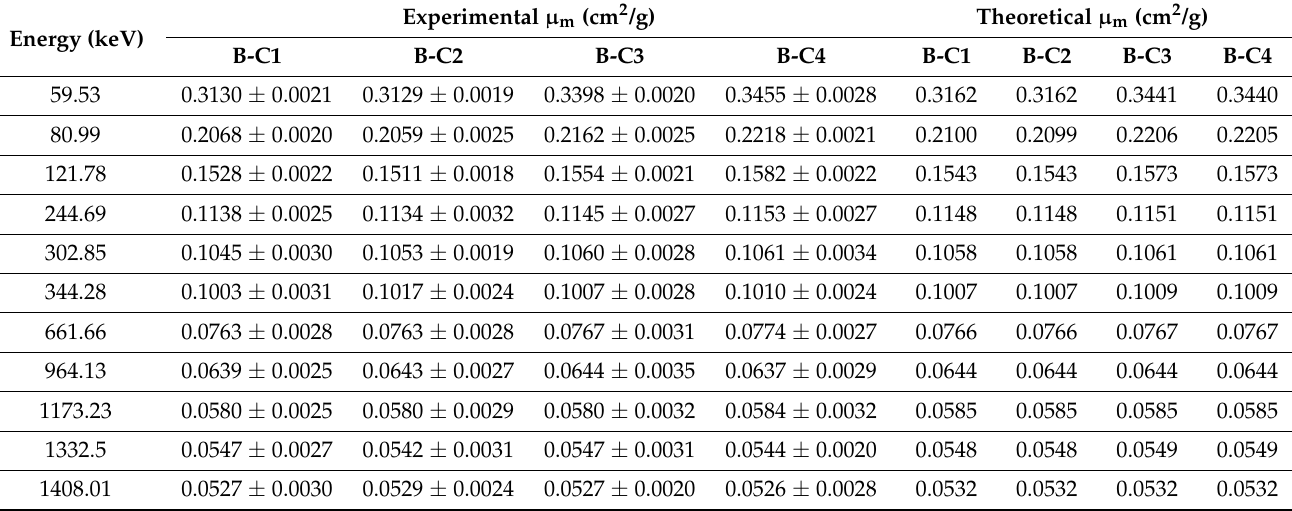
Table 3. The theoretical and experimental mass attenuation